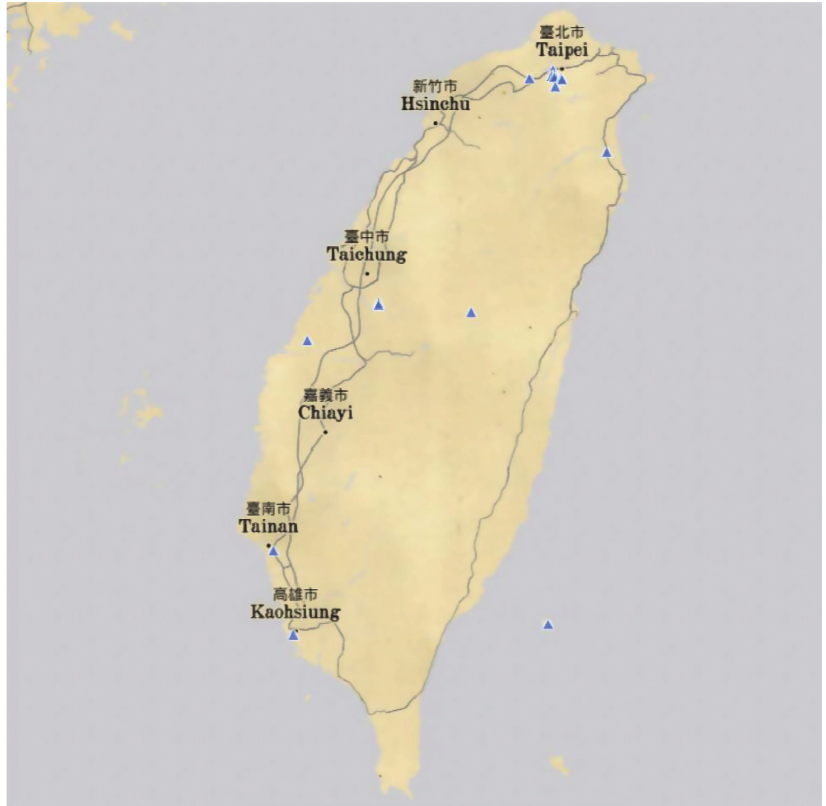
Figure 1: Map of human rights-themed cultural assets in